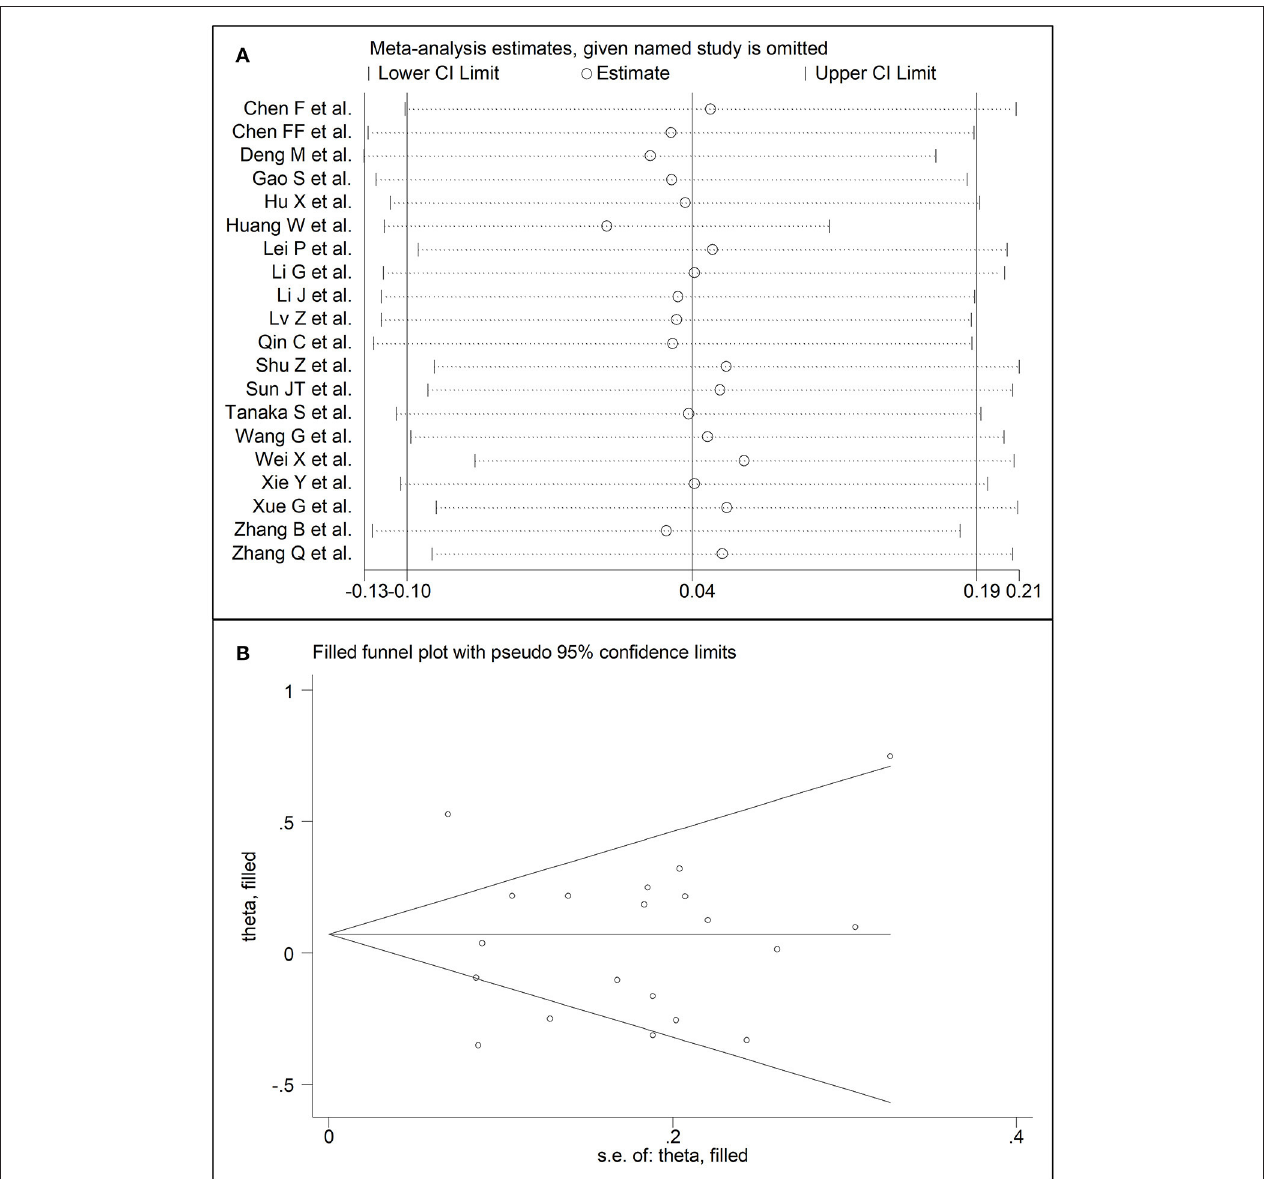
FIGURE 9 | (A) Sensitivity analysis of the association between serum triglycerides and COVID-19. The influence of individual studies on the overall standardized mean difference (SMD) is shown. The middle vertical axis indicates the overall SMD and the two vertical axes indicate the 95% confidence intervals (CIs). The hollow circles represent the pooled SMD when the remaining study is omitted from the meta-analysis. Two ends of each broken line represent the 95% CIs. (B) Funnel plot of studies investigating low vs. high severity or surviving vs. non-surviving status after trimming and filling. Dummy studies and genuine studies are represented by enclosed circles and free circles,